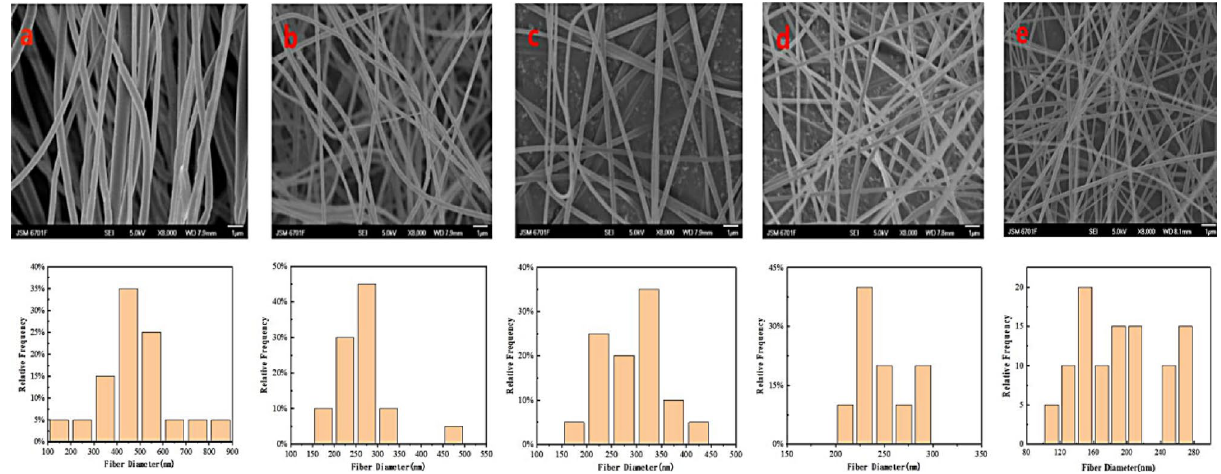
Figure 2. SEM images of electrospinning CMKN fibers with different cellulose ratio and fiber diameter distribution (( a ): 5%; ( b ):10%; ( c ):15%; ( d